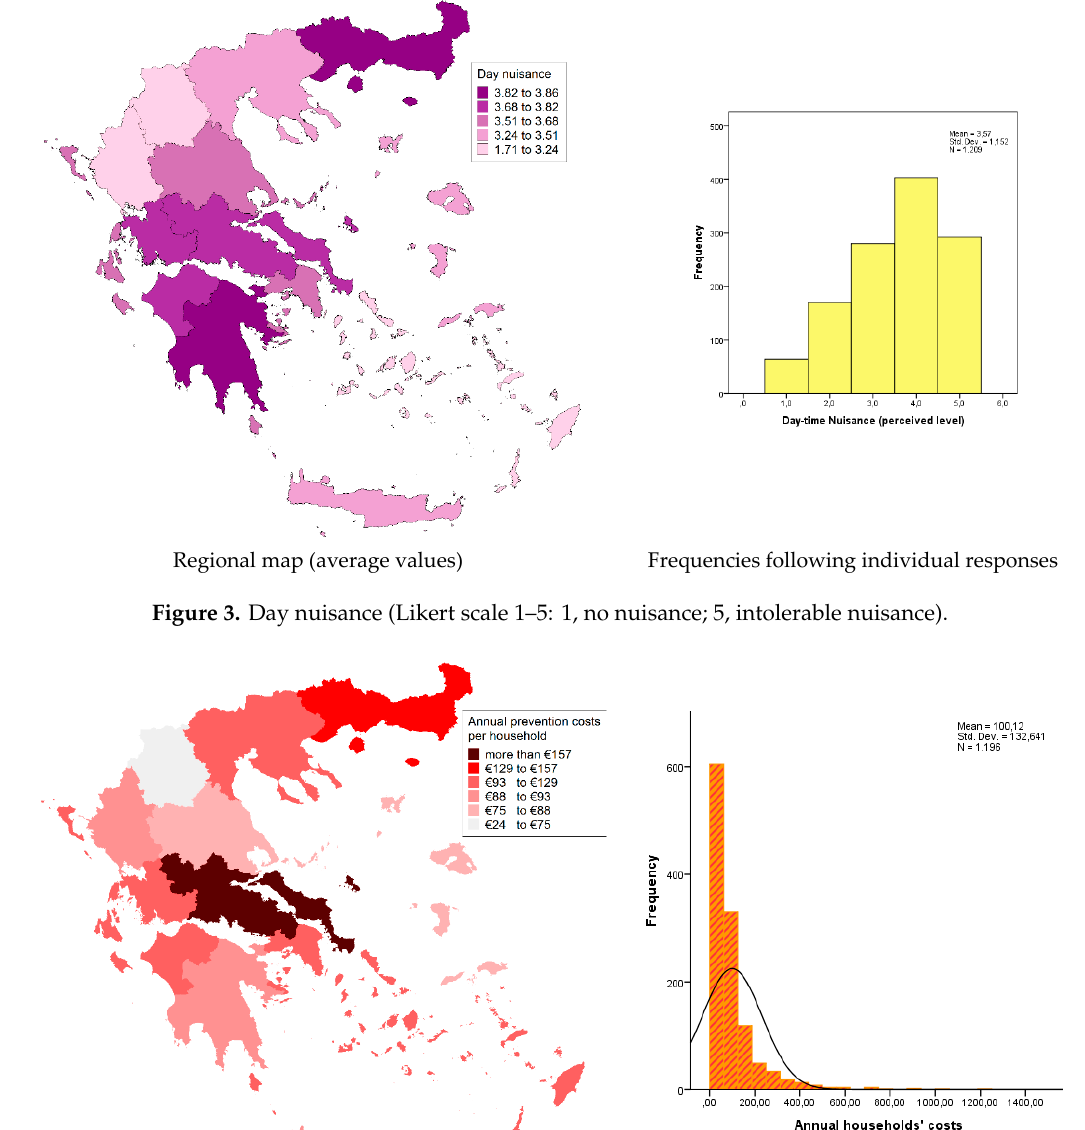
Figure 2. Night nuisance (Likert scale 1–5: 1, no nuisance; 5, intolerable nuisance).